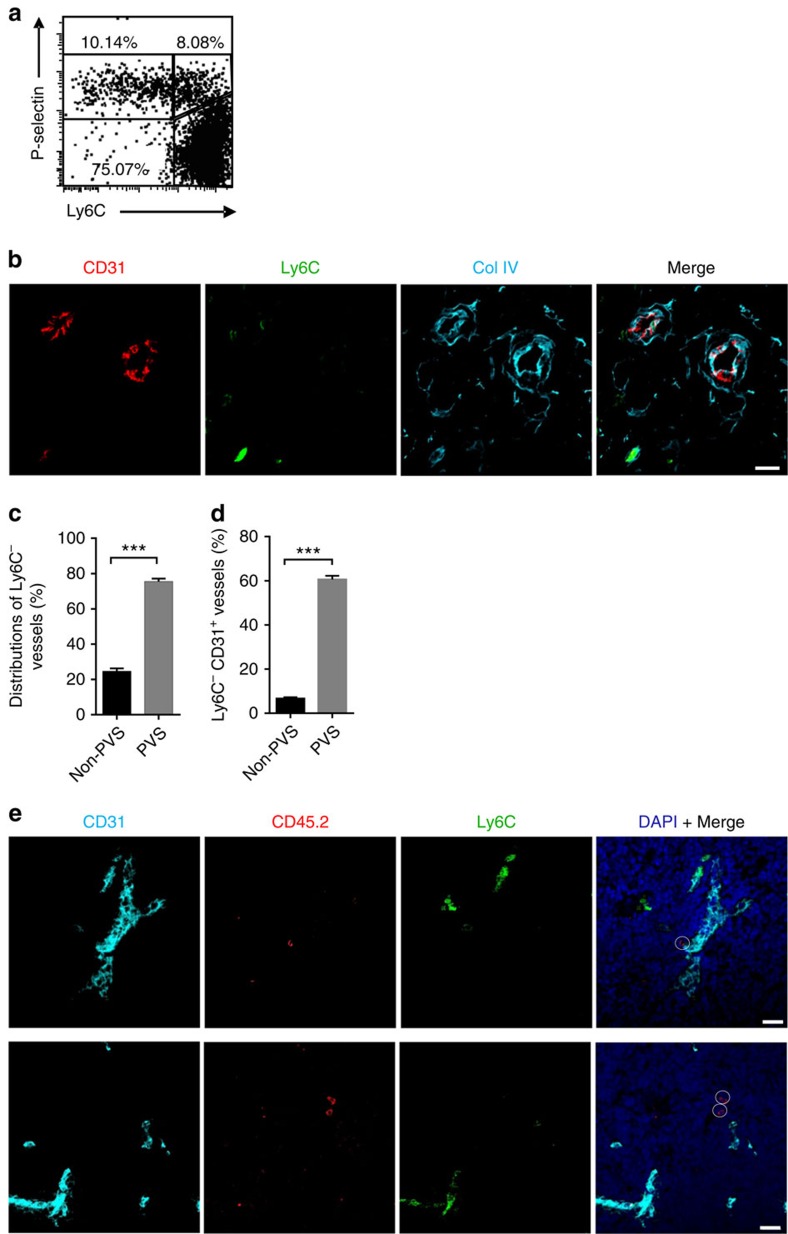
Ly6C−Selp+ thymic ECs are the specialized population associated with perivascular spaces and immigrating progenitor cells.(a) Flow cytometric analysis of P-selectin and Ly6C expression on thymic ECs from WT mice, gated on the CD45−EpCAM−CD31+ cell population, as shown in Supplementary Fig. 7a. (b) Immunofluorescence analysis of Ly6C (green) expression on CD31+ (red) thymic ECs associated with perivascular spaces, which were defined with double-basement membrane staining of collagen IV (cyan). Scale bars, 20 μm. (c) Statistical analysis of the distribution of Ly6C−CD31+ thymic ECs in PVS and non-PVS areas. (d) Statistical analysis of the percentages of PVS or non-PVS associated with Ly6C−CD31+ thymic ECs. (e) Representative images showing the location of thymic seeding progenitor cells (CD45.2+, circled red) closer to Ly6C− vessels. Scale bars, 20 μm. The data are representatives of at least three independent experiments (a,b,e); for statistical analysis (c,d), >40 fields (× 100) containing at least six non-PVS- or PVS-associated vessels from six WT mice were included for analysis. Error bars represent s.e.m. Asterisks mark statistically significant difference (***P<0.001 determined by two-tailed unpaired Student's t-test).